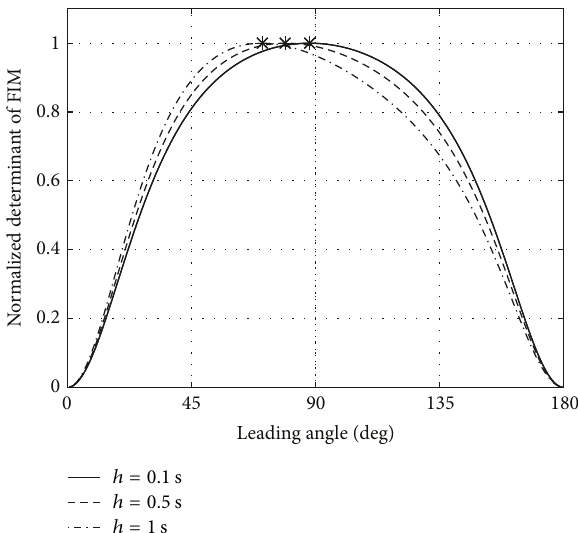
Figure 2: Normalized determinant of FIM with respect to leading angle.